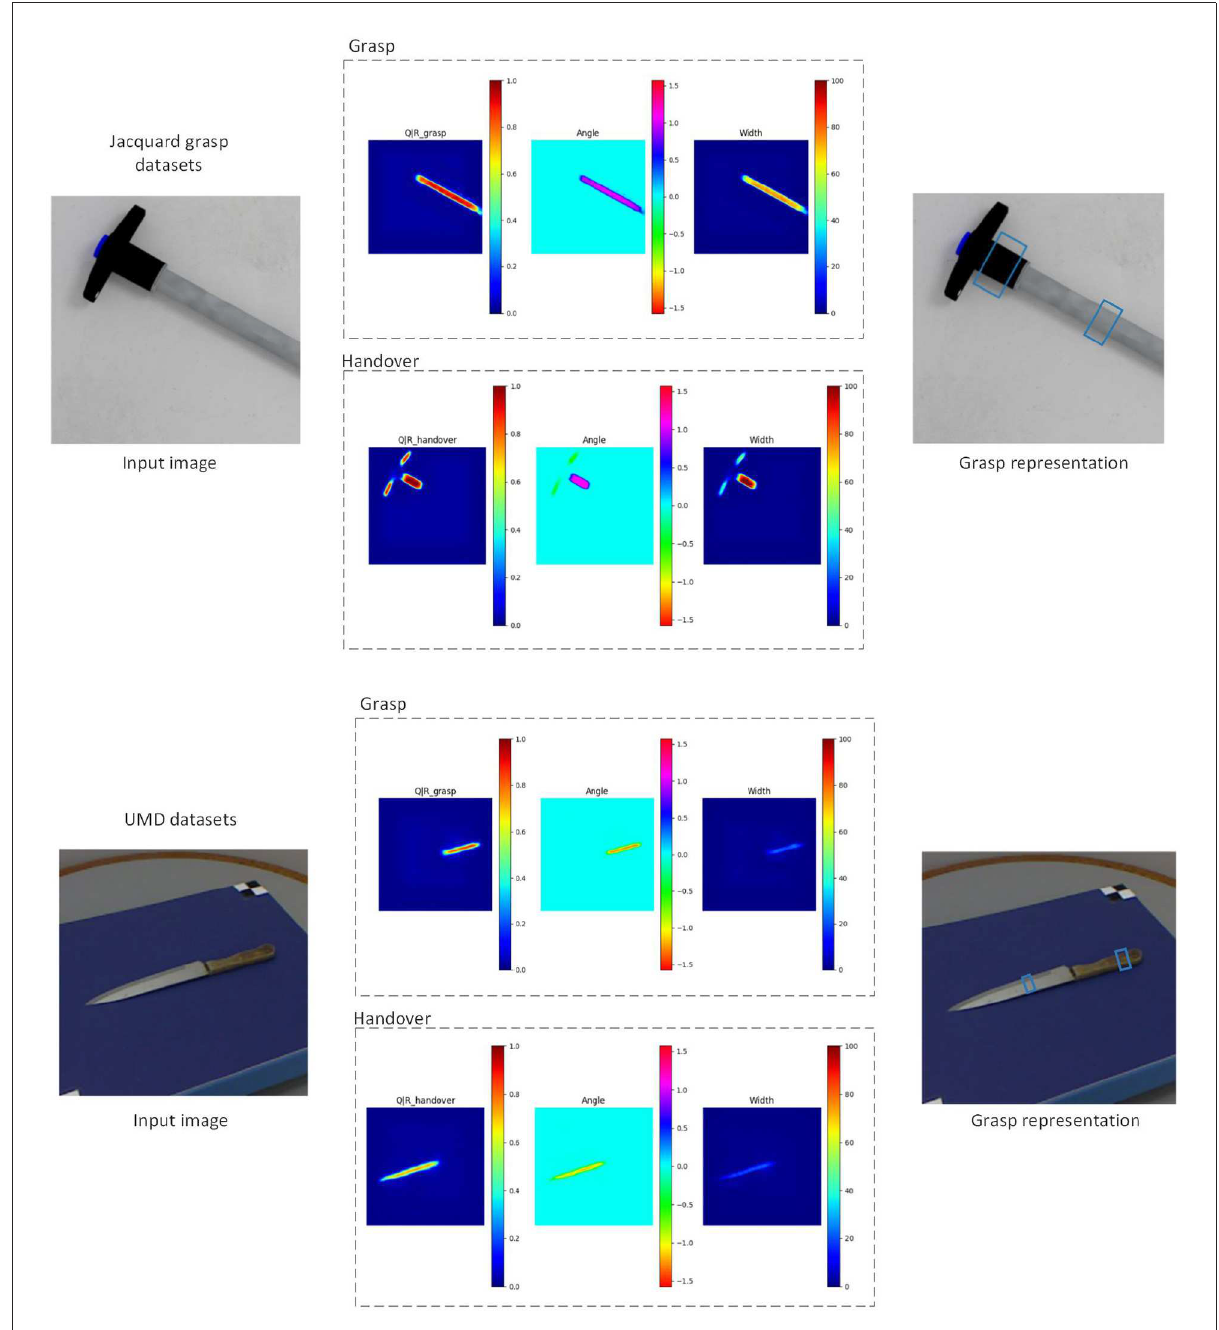
FIGURE4 Qualitative results on different